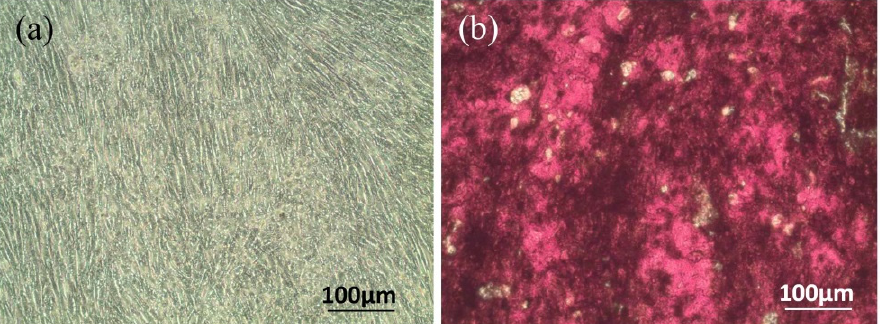
Figure 3. Osteogenic test of the dental pulp stem cells used in this study. ( a ) No mineralized nodule deposition was found in cells cultured with general medium. ( b ) In the osteogenic group, nodule-like structure depositions stained in red were observed throughout the cell layer.